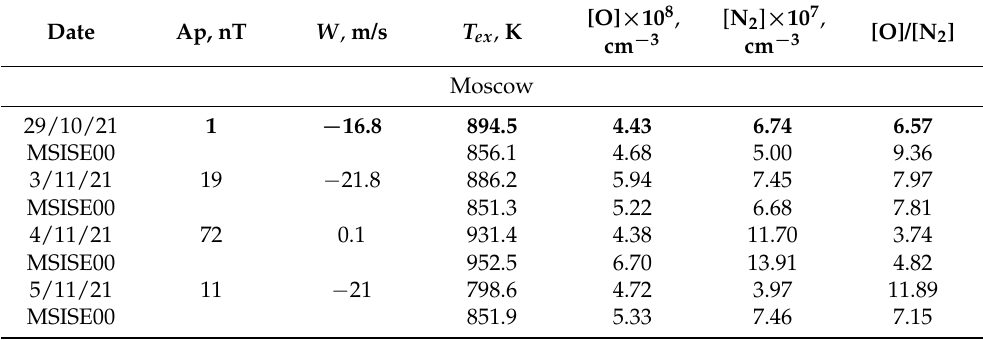
Table 1. Geomagnetic Ap index, vertical plasma drift W , exospheric temperature T ex , and neutral composition ([O], [N 2 ] and [O]/[N 2 ] ratio) retrieved at Moscow, Juliusruh, Pruhonice, Rome, and Millstone Hill at 12 LT. Retrieved exospheric temperature and neutral composition are given in comparison with MSISE00 model values at 300 km. Data for the reference quiet geomagnetic day are given in